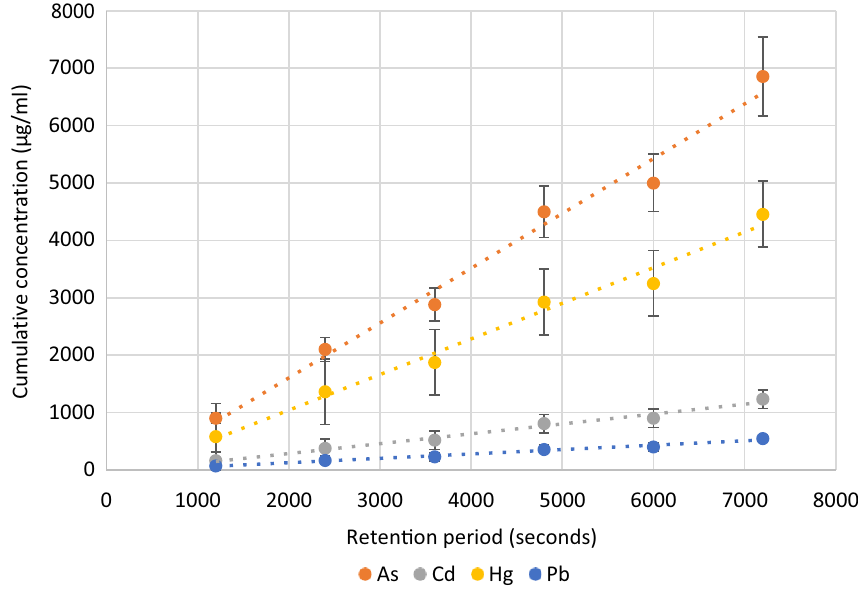
Figure 3. Time course of metal(loid) transport through Caco-2 cells for estimation of Apparent permeability (App) of metal(loid)s.